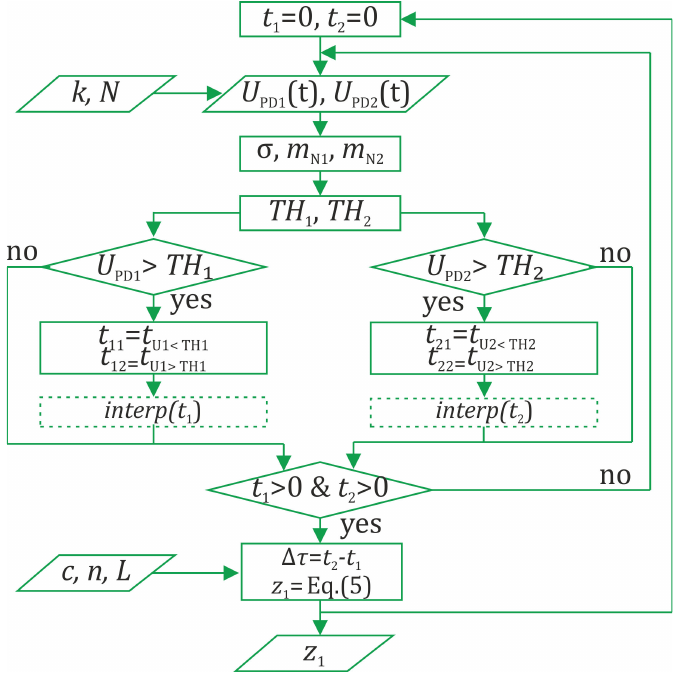
Figure 13. Data processing algorithm.